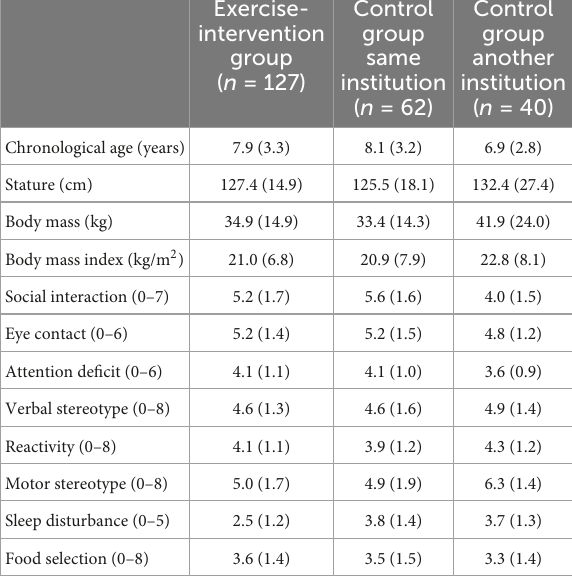
TABLE 1 Baseline characteristics of children with autism spectrum disorder grouped as intervention and control groups.